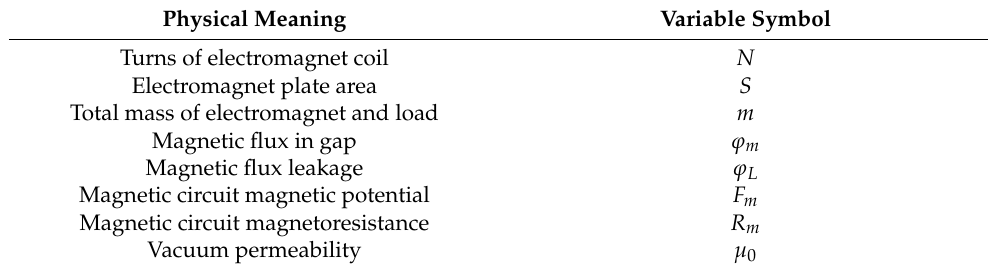
Figure 3. Structure model of single electromagnet. Table 1. Main parameters of suspension